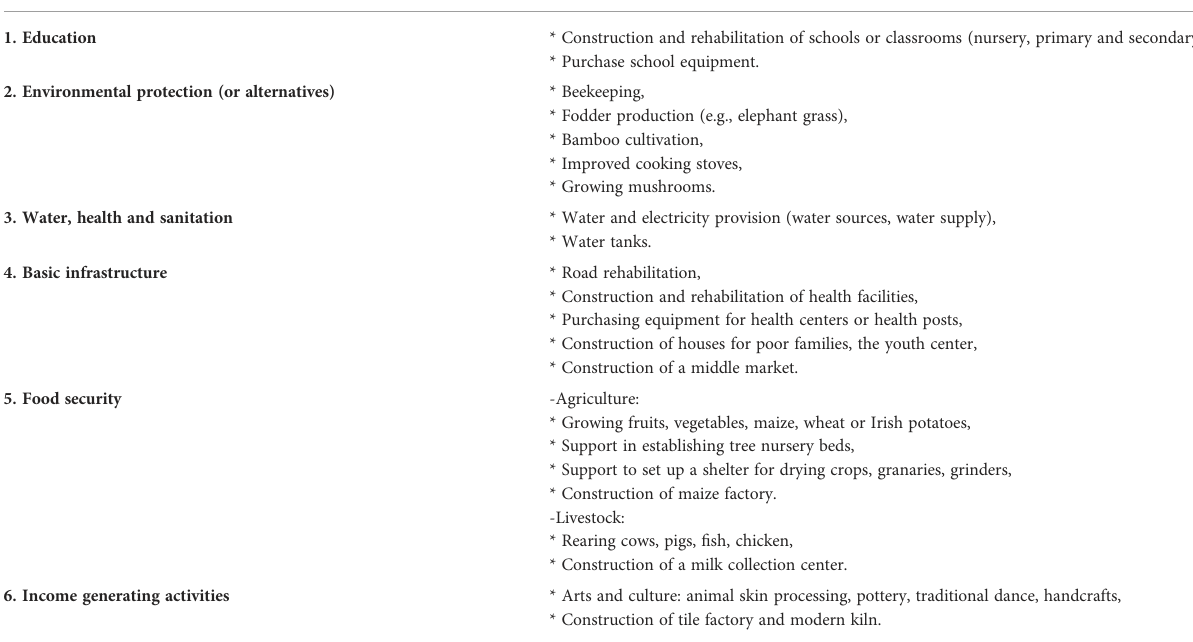
TABLE 2 Categories of the tourism revenue sharing projects around Nyungwe National Park (NNP), Rwanda. Project